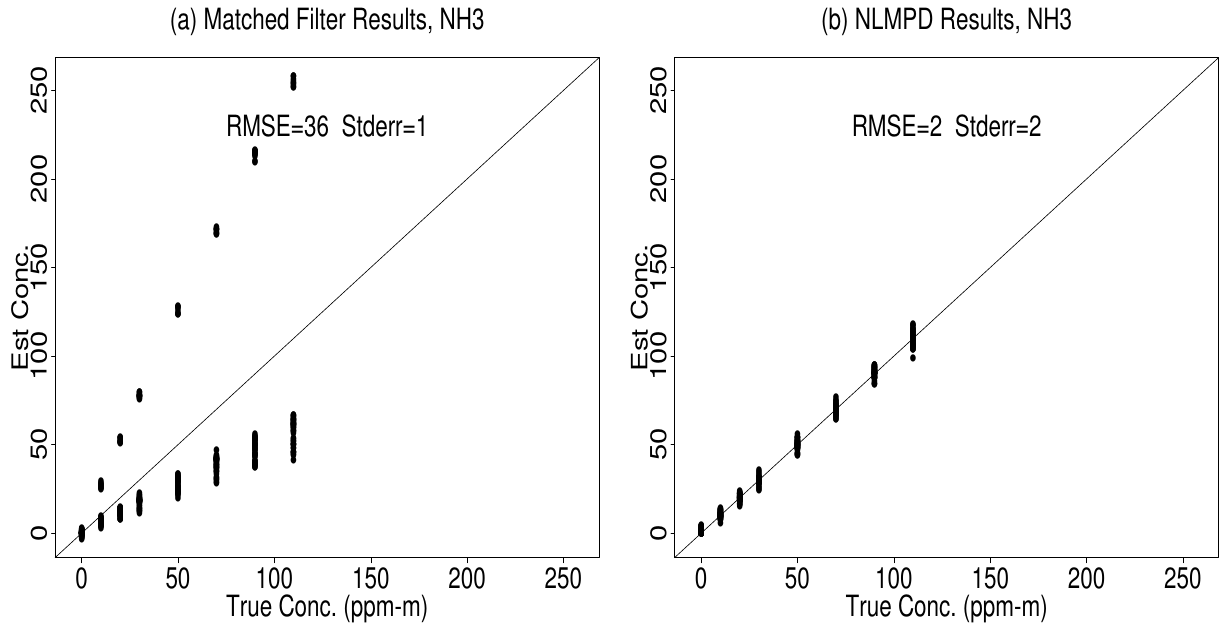
Figure 2 . Matched-Filter Estimator Compared to NLBR